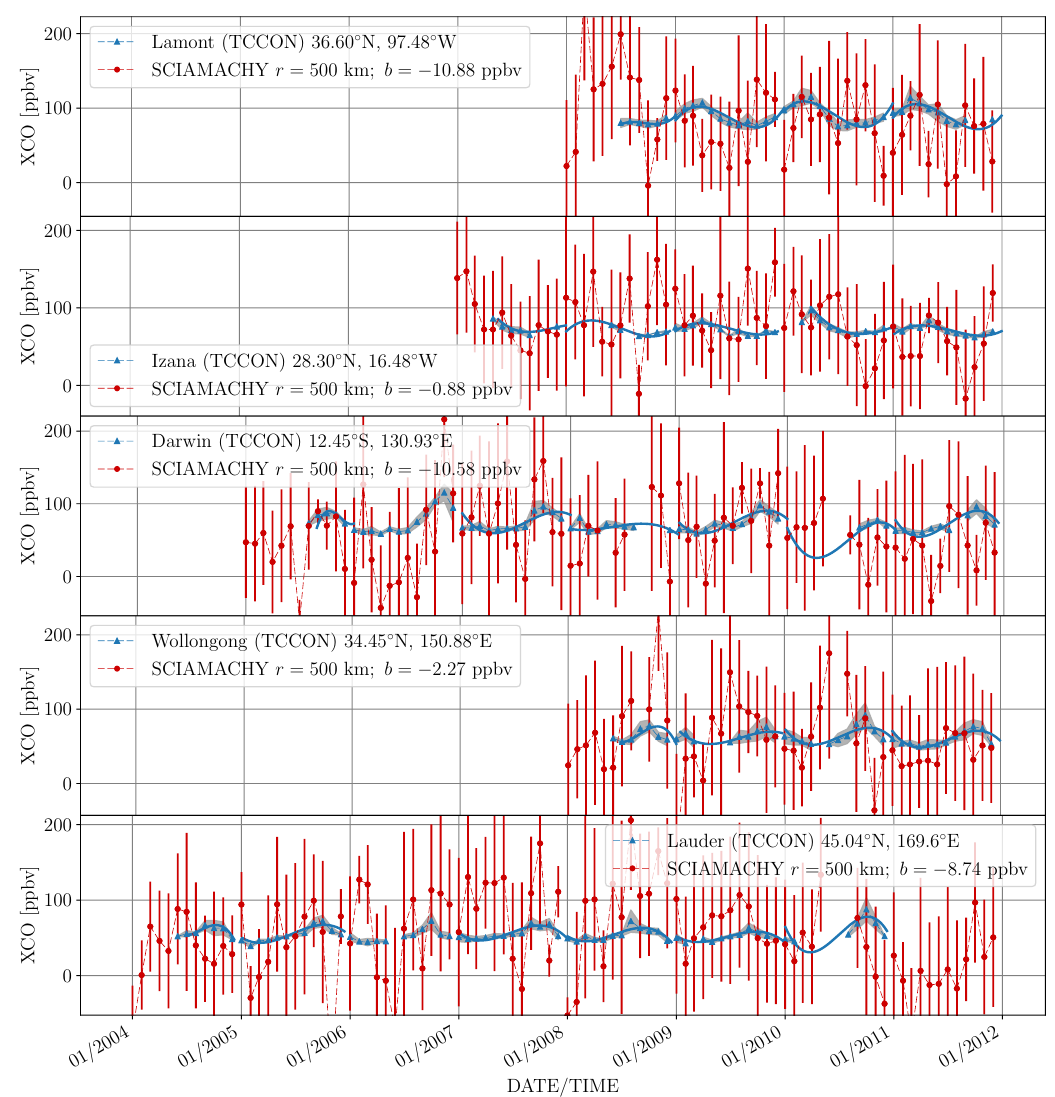
Figure 15. Time series as in Figure 14 but for the TCCON stations. Sites that provided retrievals according to the GGG2014 data release of TCCON were used for the comparison to the BIRRA